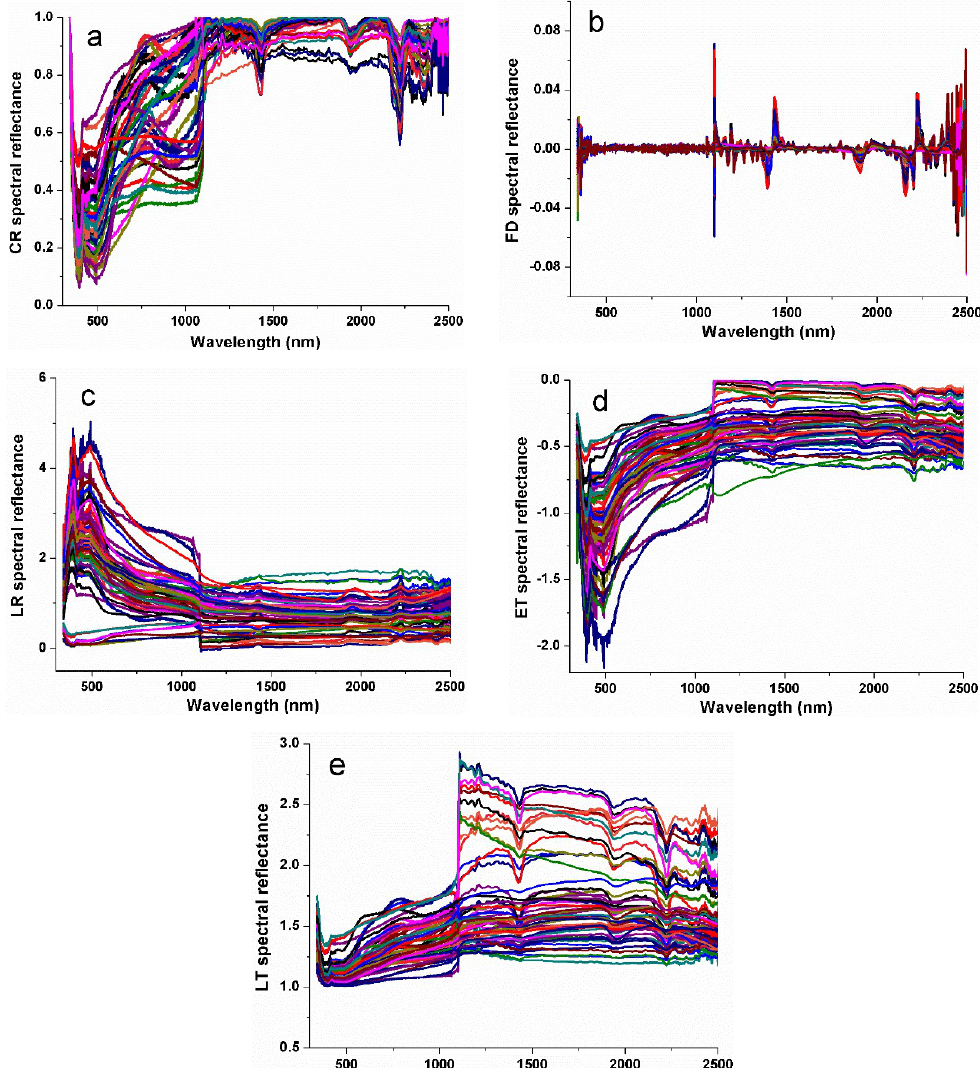
Figure 4. Transformation spectral indices of dry soil: ( a ) continuum removal spectral curves; ( b ) first-order di ff erential spectral curves; ( c ) reciprocal logarithmic spectral curves; ( d ) exponential transformation spectral curve; and ( e ) logarithmic transformation spectral curves.